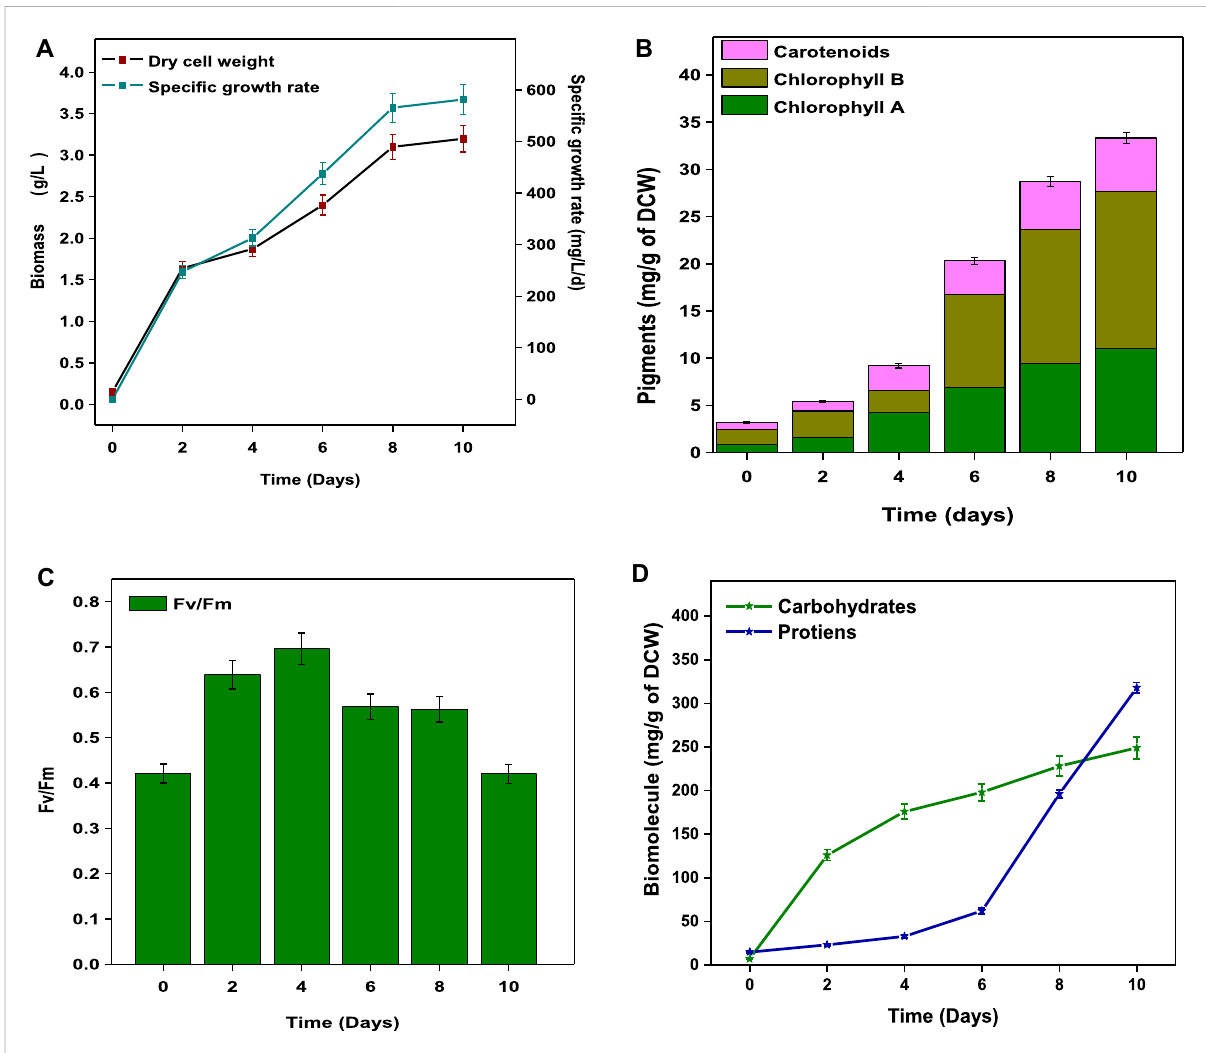
2019). Intracellular free nitrogen (nitrates, amino acids) directs the controlling metabolism toward carotenoid synthesis (Huang et al., 2019). The changes in the photosynthetic activity of Coelestrella sp. were also analyzed. The Fv/Fm ratios indicate the PSII (photosystem) photochemical ef fi ciency in the dark- adapted state with fully open reaction centers of the PSII system (Kona et al., 2021). Initially, the Fv/Fm value was 0.42 (day 0) and later reached a maximum value (0.69) on day 4, indicating a maximum photosynthetic activity. The ratio then gradually decreased to 0.42 by the end of cultivation (Figure 2C). The lower Fv/Fm ratios might result in carotenoid synthesis (Masojídek et al.,